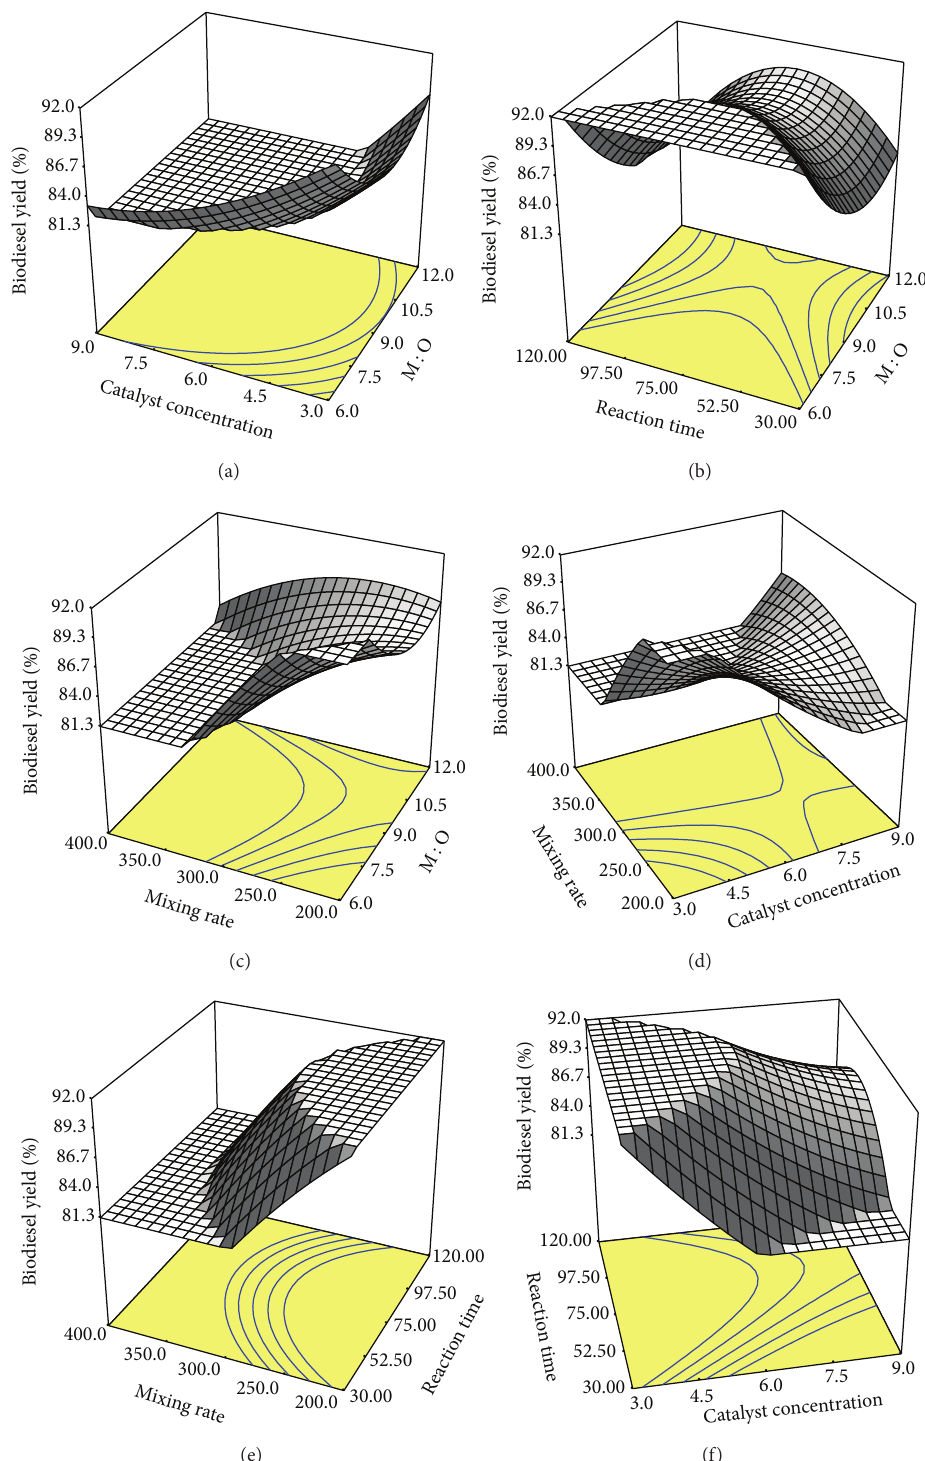
Figure 10: Response surface plots of biodiesel yield using CaO prepared from waste mollusks